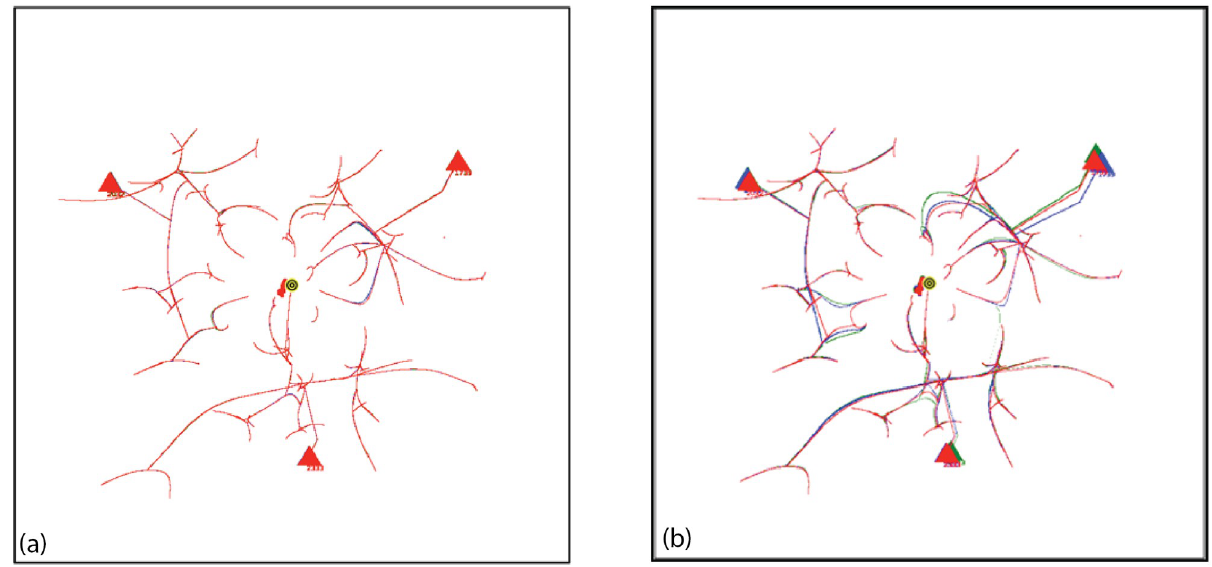
Fig 5. Overlay of multiple simulations to show the effect of variation in the coalescence radius CR , AIB = 120, standard conditions, seed = 61. A dark grey bullseye indicates the origin (0,0) in the center of the figure and the trail of a small red spot indicates the location of Center of Attributes during the simulation. a) Simulations with CR = 0.1(blue), 0.2(red/default), and 0.3(green). The red covers the blue and green tracks indicating they are almost identical; b)Simulations with CR = 0.2(red/default), 0.7(blue), and 1.5(green). Some differences are